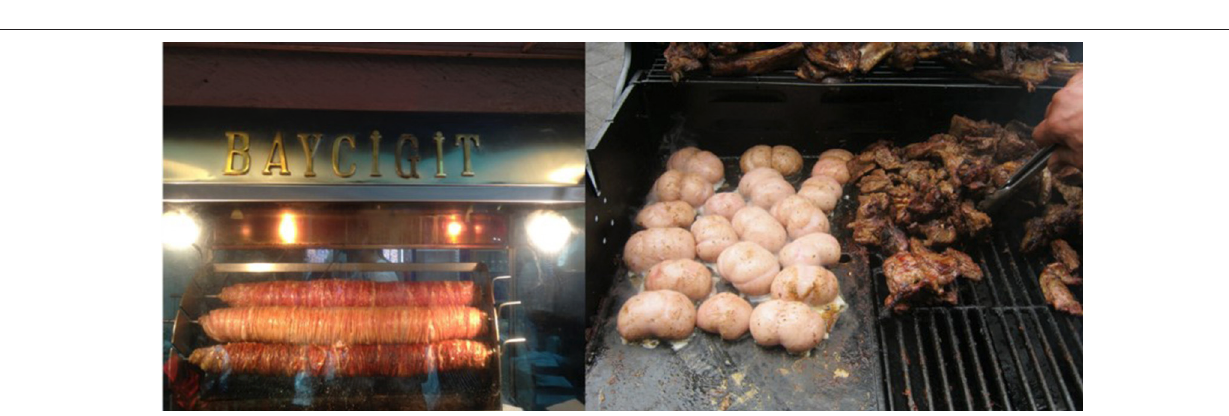
rheological, textural, and nutritional properties (85, 86).